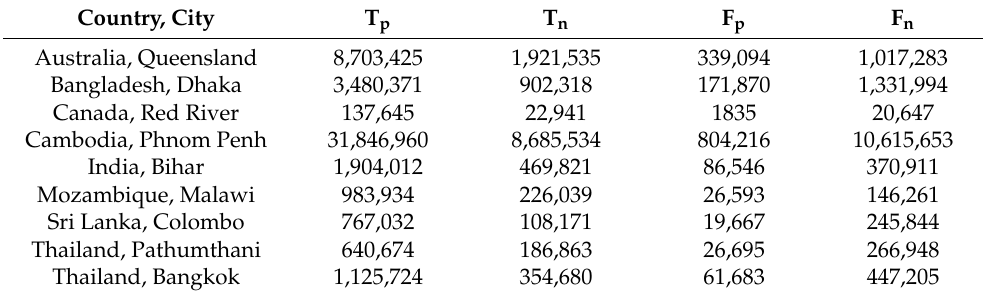
Table 4. FMA performance metrics for the flood events (number of pixels, 30 m resolution). Country, City T p T n F p